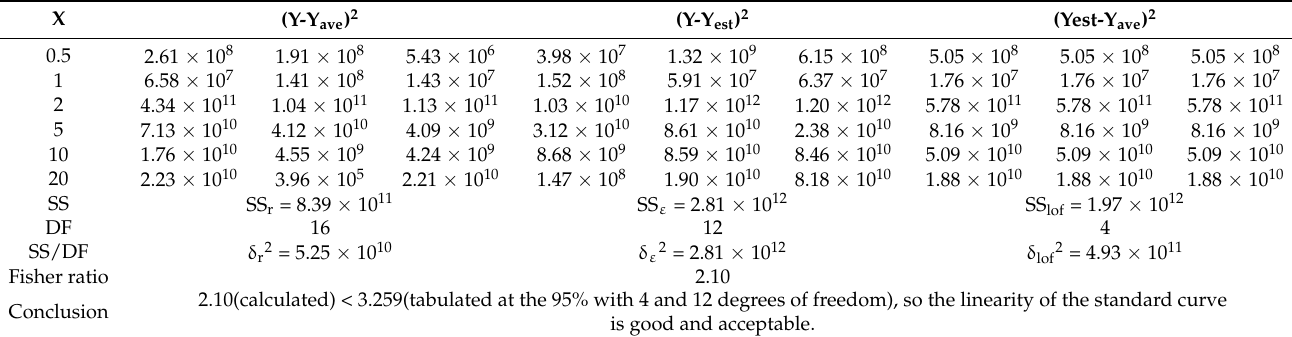
Table 2. The calculation process of F value.